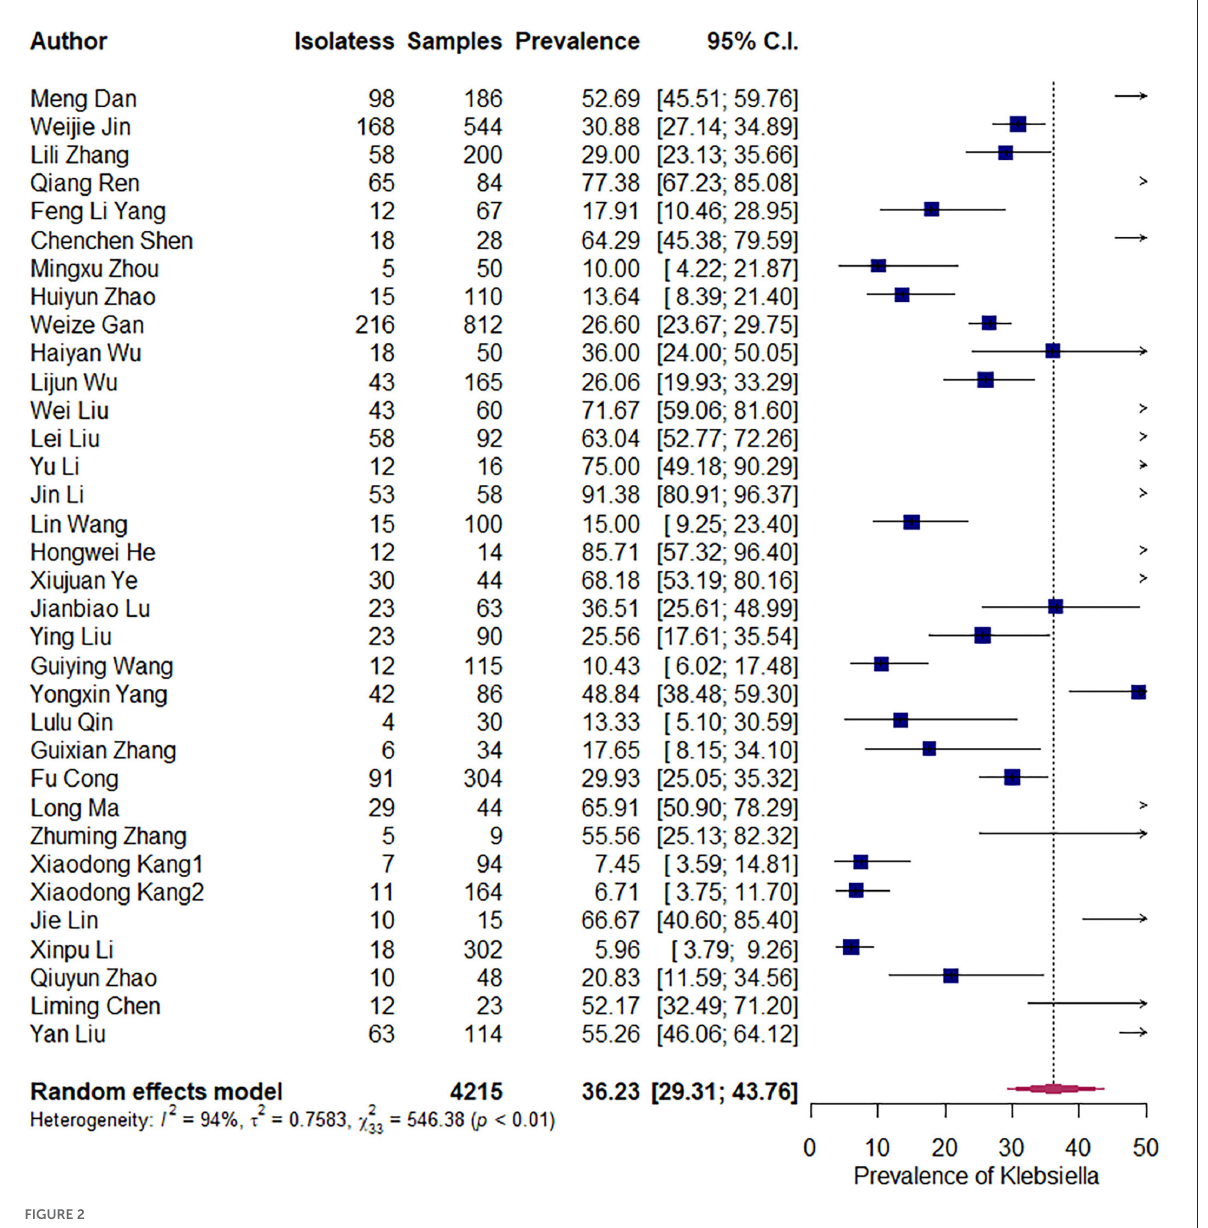
FIGURE2 Overall prevalence of Staphylococcus aureus